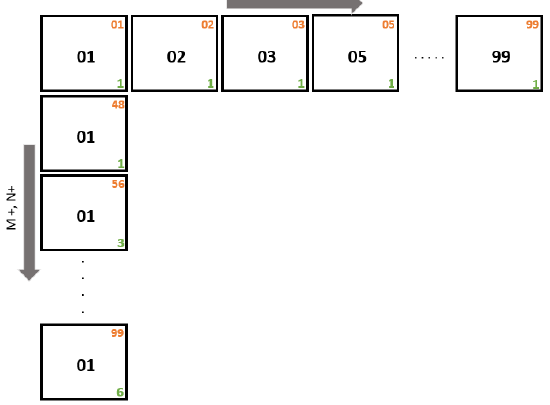
Figure 10. Representation of the periodic table of industries